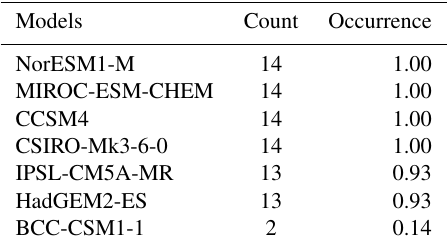
Table C4. Absolute and relative occurrence of each individual model included in the Antarctica top three combinations presented in Table C3.